Question: Write a caption explaining this figure to a reader.
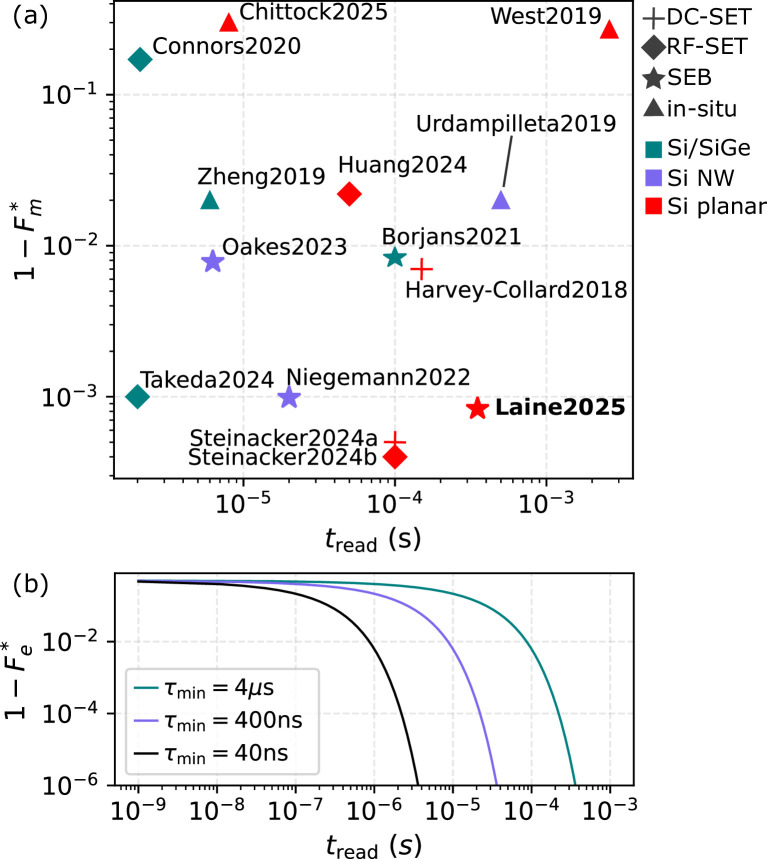
Answer: Spin readout fidelity in the literature and possible improvement. ( a ) Spin readout fidelity using Pauli Spin Blockade across platforms and sensors. The data and references can be found in Extended Table 1. ( b ) Electrical fidelity plotted from Eq. ( 12 ) with voltage SNR taken as \documentclass[12pt]{minimal} \usepackage{amsmath} \usepackage{wasysym} \usepackage{amsfonts} \usepackage{amssymb} \usepackage{amsbsy} \usepackage{mathrsfs} \usepackage{upgreek} \setlength{\oddsidemargin}{-69pt} \begin{document}$${\rm{S}}NR=\sqrt{{t}_{{\rm{read}}}/{\tau }_{\min }}$$\end{document} S N R = t read / τ min . The spin \documentclass[12pt]{minimal} \usepackage{amsmath} \usepackage{wasysym} \usepackage{amsfonts} \usepackage{amssymb} \usepackage{amsbsy} \usepackage{mathrsfs} \usepackage{upgreek} \setlength{\oddsidemargin}{-69pt} \begin{document}$${\tau }_{\min }$$\end{document} τ min for this work is estimated to \documentclass[12pt]{minimal} \usepackage{amsmath} \usepackage{wasysym} \usepackage{amsfonts} \usepackage{amssymb} \usepackage{amsbsy} \usepackage{mathrsfs} \usepackage{upgreek} \setlength{\oddsidemargin}{-69pt} \begin{document}$${\eta }^{-1}\times {\tau }_{\min } \sim 4.1\mu$$\end{document} η - 1 × τ min ~ 4 . 1 μ s (Appendix I) which incorporates the loss of visibility η −1 due to distinguishing (0, 2) and (1, 1) Coulomb peaks when spin sensing. This shows that reducing our current SEB \documentclass[12pt]{minimal} \usepackage{amsmath} \usepackage{wasysym} \usepackage{amsfonts} \usepackage{amssymb} \usepackage{amsbsy} \usepackage{mathrsfs} \usepackage{upgreek} \setlength{\oddsidemargin}{-69pt} \begin{document}$${\tau }_{\min }$$\end{document} τ min by an order of magnitude would allow to reach readout fidelity of 99% under 10 μ s.